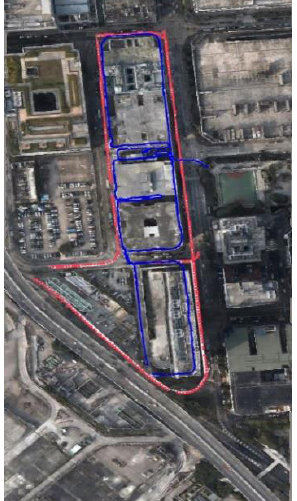
Figure 6. Experimental area and image distribution. The red and blue lines indicate the trajectories of the MMS and backpack systems, respectively.